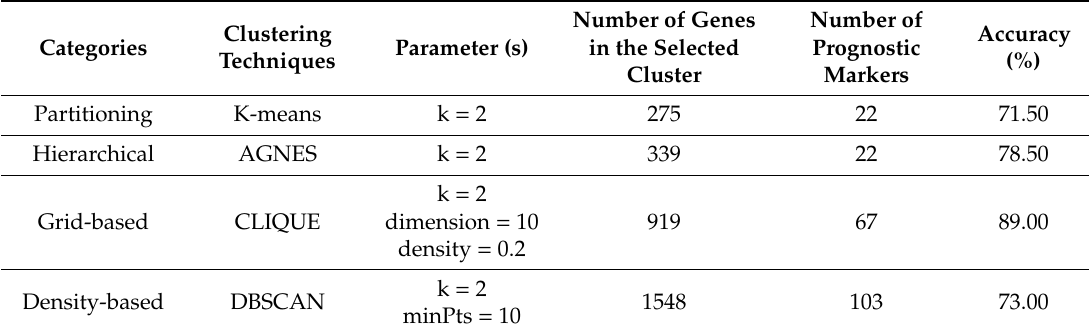
Table 3. Comparative results of the clustering technique applied on leukemia gene expression